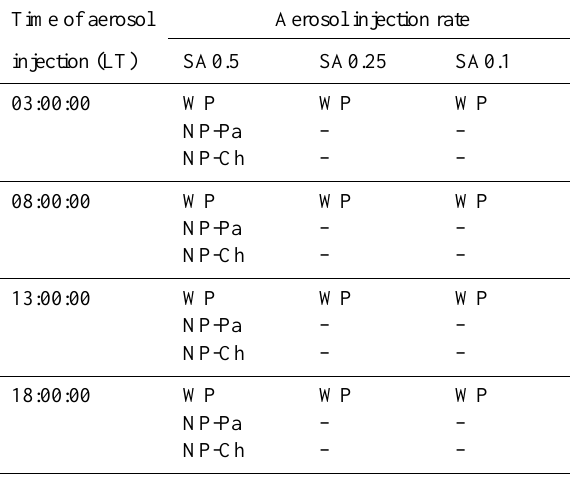
Table 1. Aerosol injection experiments. WP indicates aerosol injec- tion into the weakly precipitating control case. NP-Pa and NP-Ch indicate aerosol injection into the non-precipitating cases initialised with aerosol concentrations associated with the North-East Pacific (intermediately polluted) and the East China Sea (heavily polluted) respectively. SA0.5, SA0.25 and SA0.1 describe the aerosol injec- tion rate, as a fraction of the injection rate proposed by Salter et al.